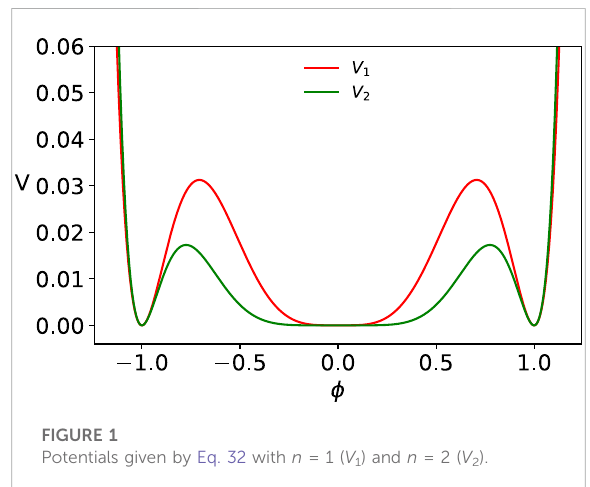
FIGURE 1 Potentials given by Eq. 32 with n = 1 ( V 1 ) and n = 2 ( V 2 ).